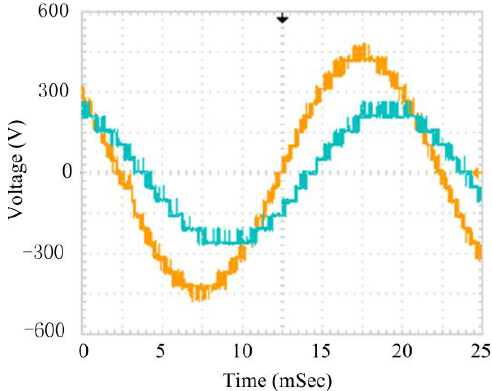
Figure 16. Experimental phase voltage and line voltage under discontinuous modulation strategy (Modulation depth, M = 0.95).